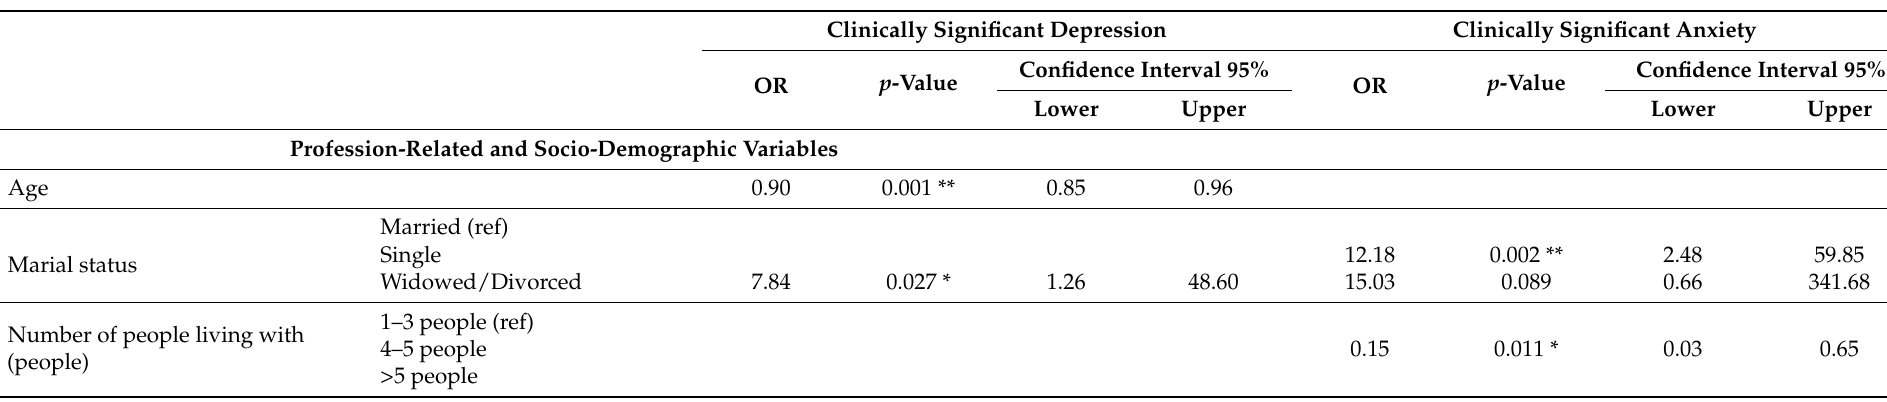
Table 5. Analysis of factors associated with the symptoms of depression and anxiety, respectively: multivariate stepwise logistic